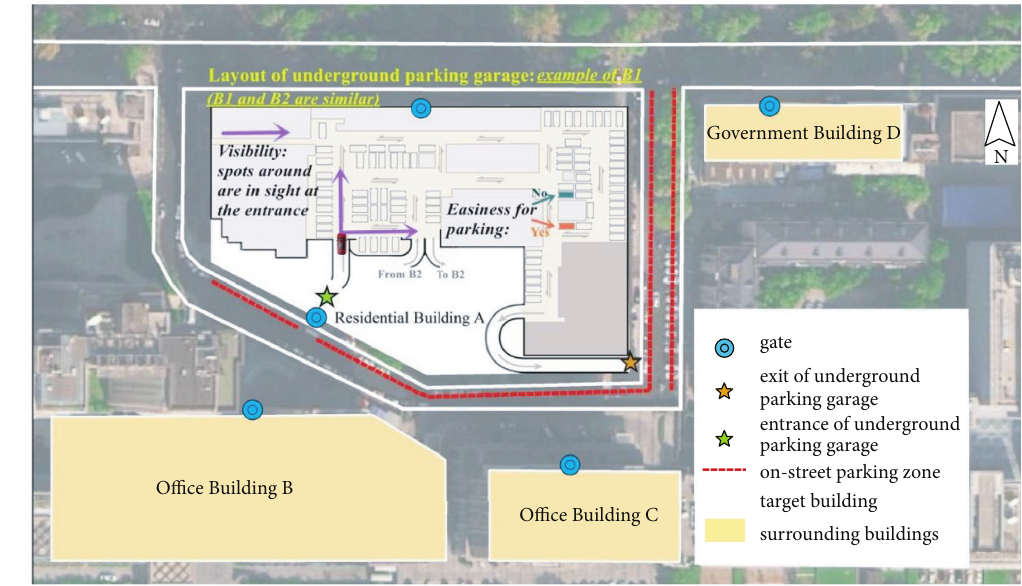
Figure 2: Location of the research area. Table 1: Descriptive statistics of